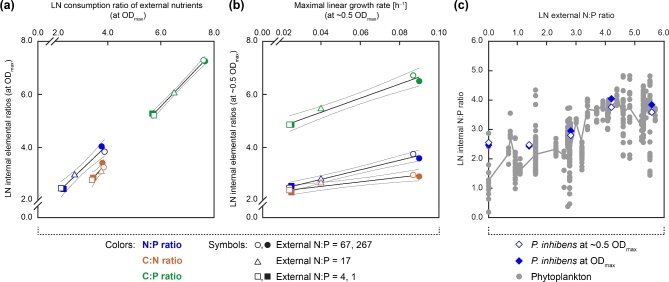
Imprint of external NH4+ and PO43− supply ratios on internal elemental stoichiometry of P. inhibens. (a) Internal elemental ratios for C, N, and P as a function of the consumption ratio of glucose, NH4+ and PO43− (both at ODmax). (b) Relation of maximal linear growth rate (μlin) to internal elemental ratios (both at ∼0.5 ODmax). Linear growth represented the major active growth phase, whereas exponential growth was mostly very short and confined to early growth. Values for μlin were largest during P-limitation, whereas the exponential growth rate (μexp; Table 1) was higher under P-excess (as to be expected from the growth rate hypothesis; Elser et al.2000). (c) Internal N:P ratios of P. inhibens (blue) and phytoplankton (gray) as a function of external N:P ratios. Phytoplankton data (from marine and freshwater species) were compiled from a meta-analysis of phytoplankton stoichiometry and growth rate (Hillebrand et al.2013). The gray line displays the median across the phytoplankton data. LN represents the natural logarithm.